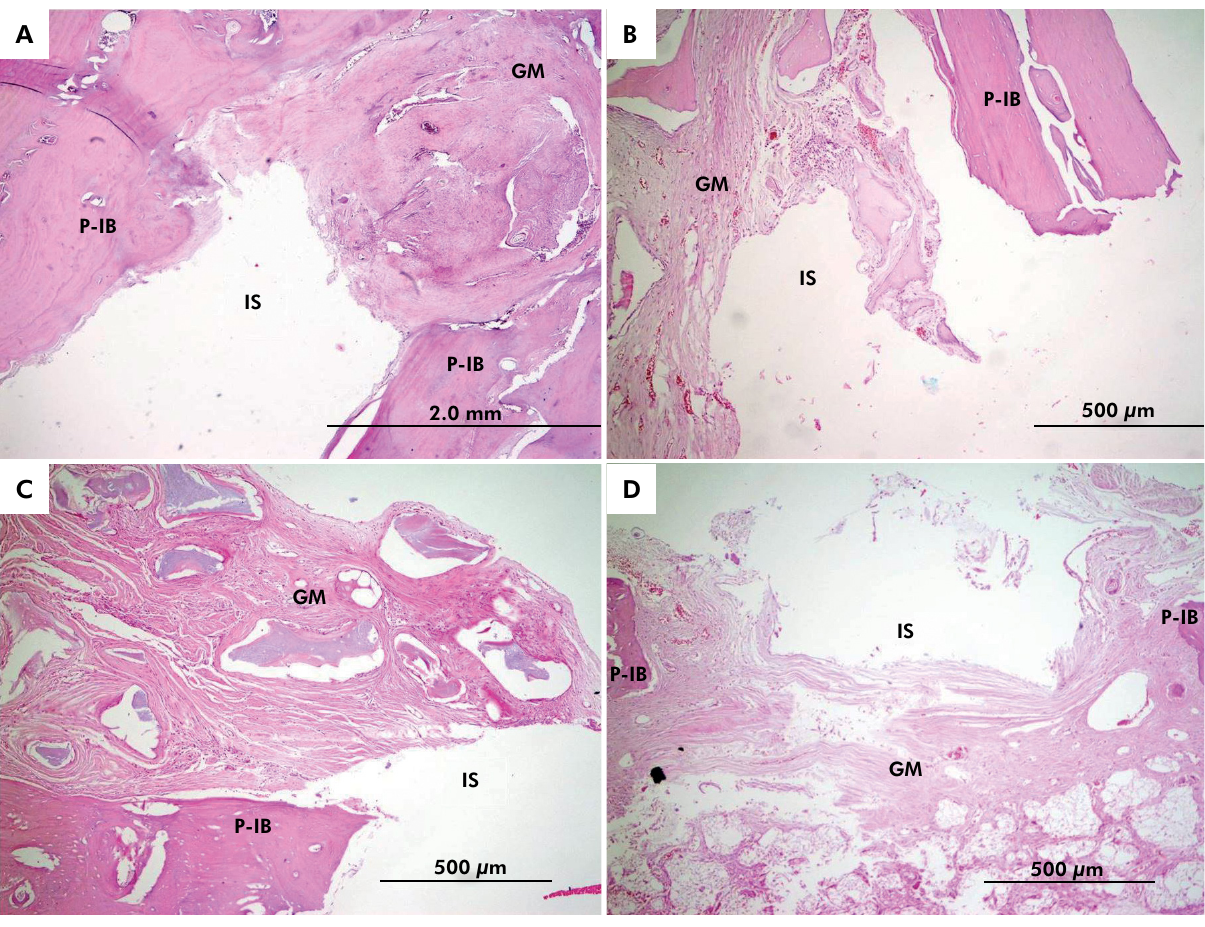
Figure 1. Histological images of a) calcium sulfate, b) deproteinized bovine, c) human-derived allogenic, and d) hydroxyapatite bone grafts. Hematoxylin and eosin